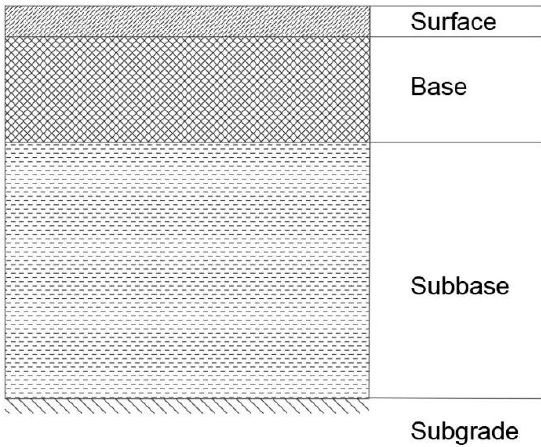
Figure 9. Schematic diagram of asphalt pavement structure layers. Table 3. Recommended scheme of pavement structure and converted composite modulus.